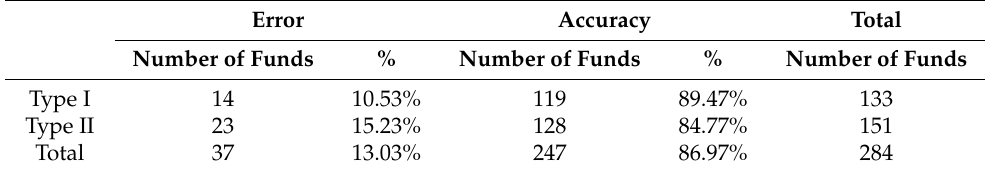
Table 4. Error and accuracy percentages.